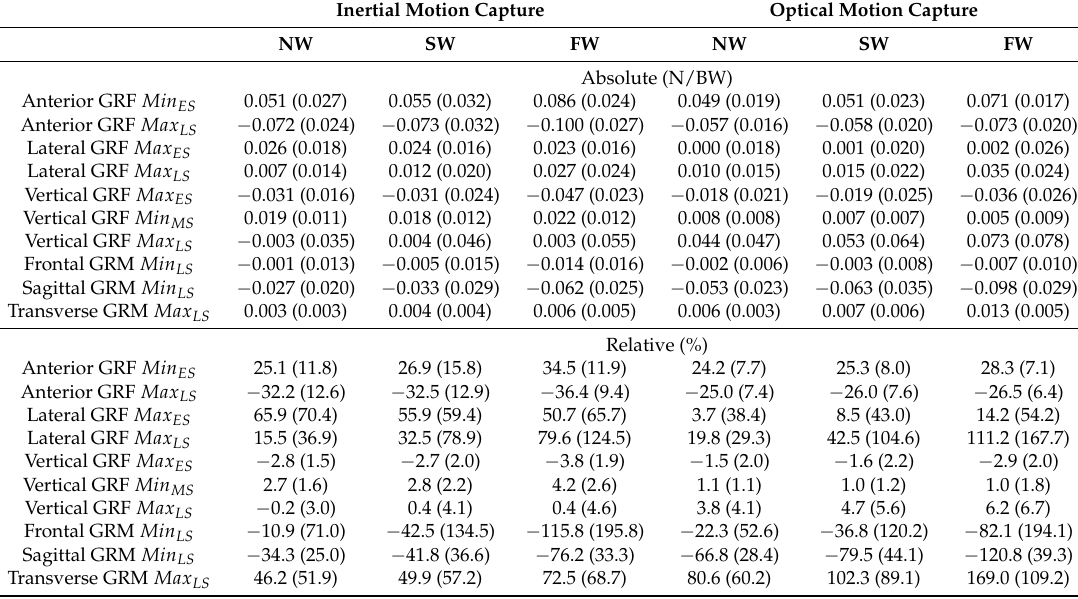
Table 8. Differences in the peak values of the ground reaction forces and moments estimated using inertial motion capture and optical motion capture versus measured using force plates. Analysis performed for normal (NW), slow (SW) and fast walking (FW) trials for the decomposed right and left quantities. The subscripts ES , MS and LS indicate the phase of stance where each peak was found (early, middle and late stance phase,